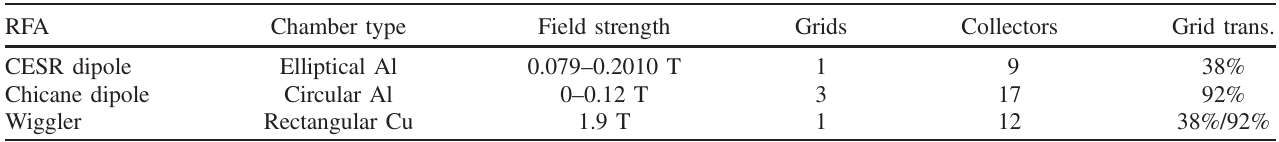
TABLE I. List of dipole/wiggler RFA locations. The elliptical and rectangular chambers are 9 cm in width by 5 cm in height. The circular chamber is 4.5 cm in radius. “ Grid trans. ” refers to the optical transparency of the grids. Note that the wiggler RFAs used two generations of grids with different